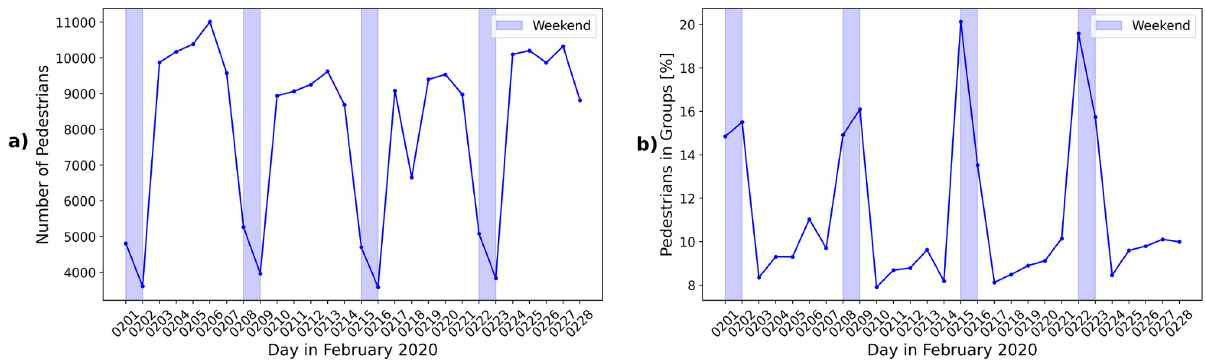
Fig 3. Number of passengers and members of social groups. a) Number of pedestrians during afternoon peak hours from 4 p.m. to 7 p.m. in February 2020 at Zu¨rich Hardbru¨cke. b) Percentage of passengers who are members of a social group detected by the group detection method. Weekends are marked as blue